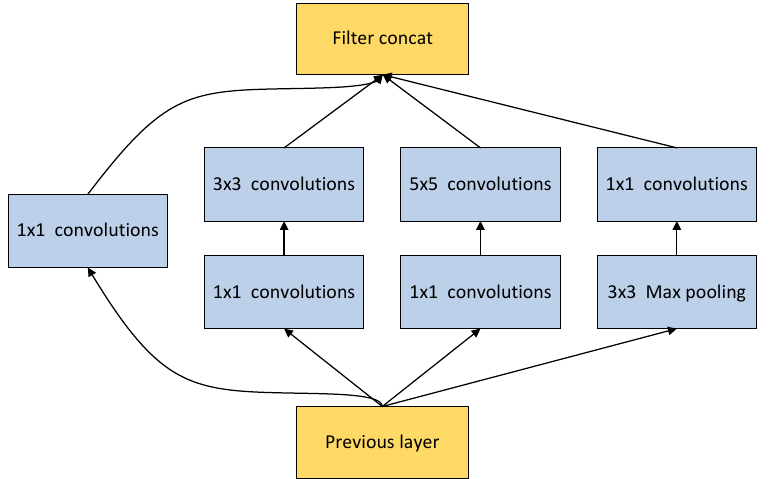
Figure 3. Inception module with dimension reductions.